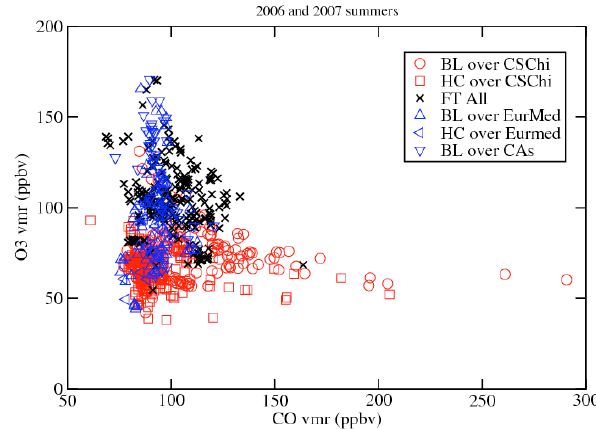
Figure 11. O 3 /CO signature of same air masses of Figure 10, but as O 3 vmr plotted as a function of CO vmr.